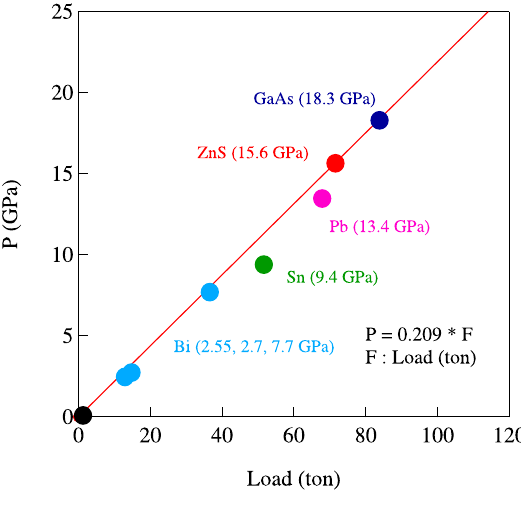
Table 1: Phase transitions as pressure calibrants [15].